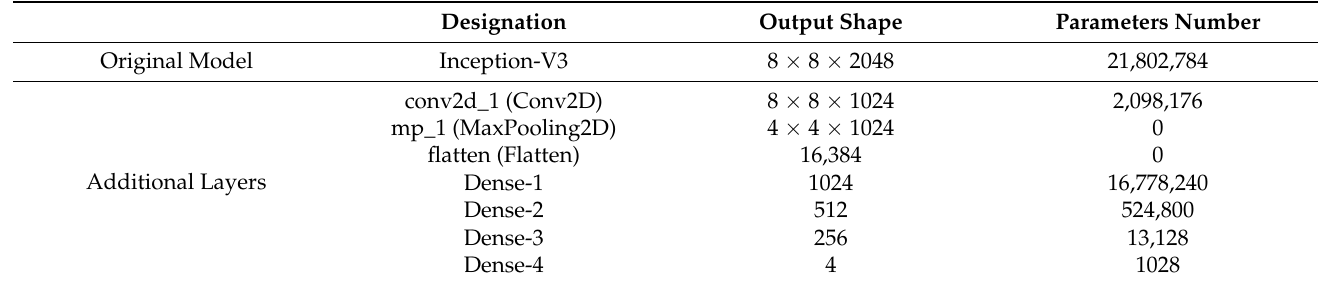
Table 5. The proposed modified-based Inception V3 model architecture.